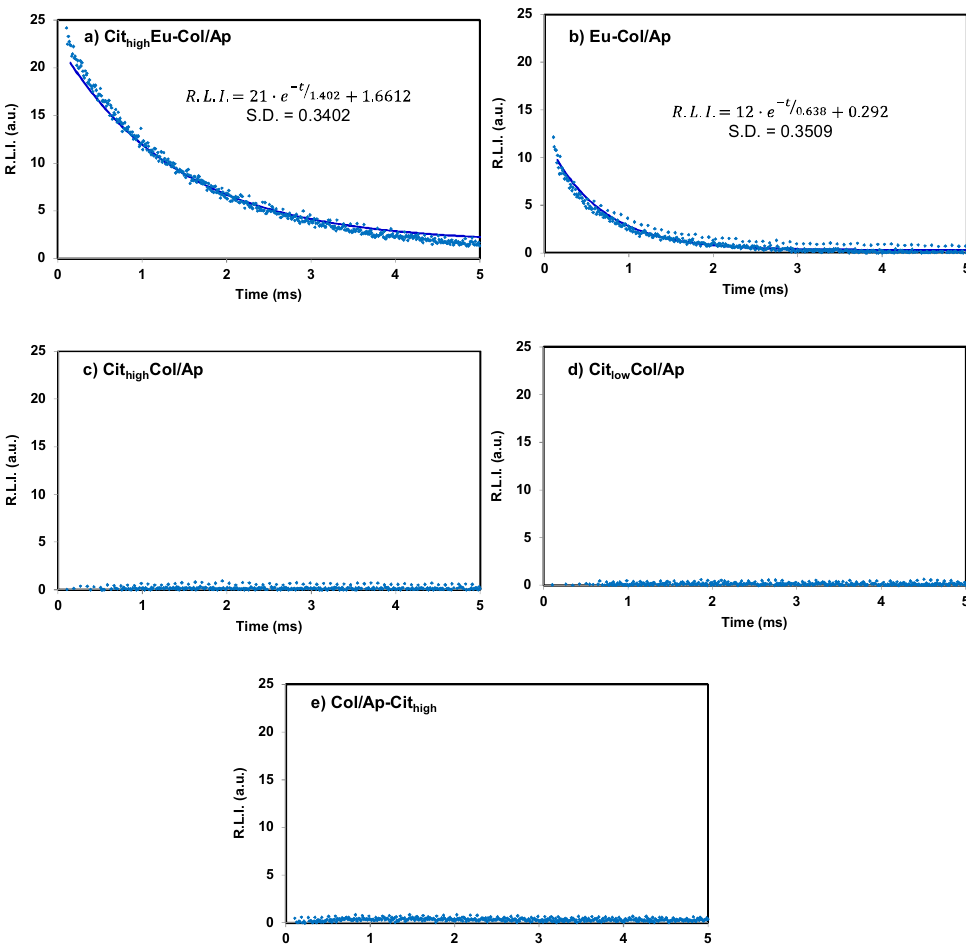
Figure 7. Luminescence decay curve of the different Eu – doped apatite mineralized collagen fibrils, i.e. ( a ) cit high –Col/Ap, ( b ) Eu-Col/Ap, ( c ) cit high –Col/Ap, ( d ) cit low –Col/Ap, and ( e ) Col/Ap–cit high λ exc/em = 240/614 nm, slit – widths exc/em = 10/0 nm, and detector voltage = 600 V. Circles correspond to experimental data and lines to the fitting equation.